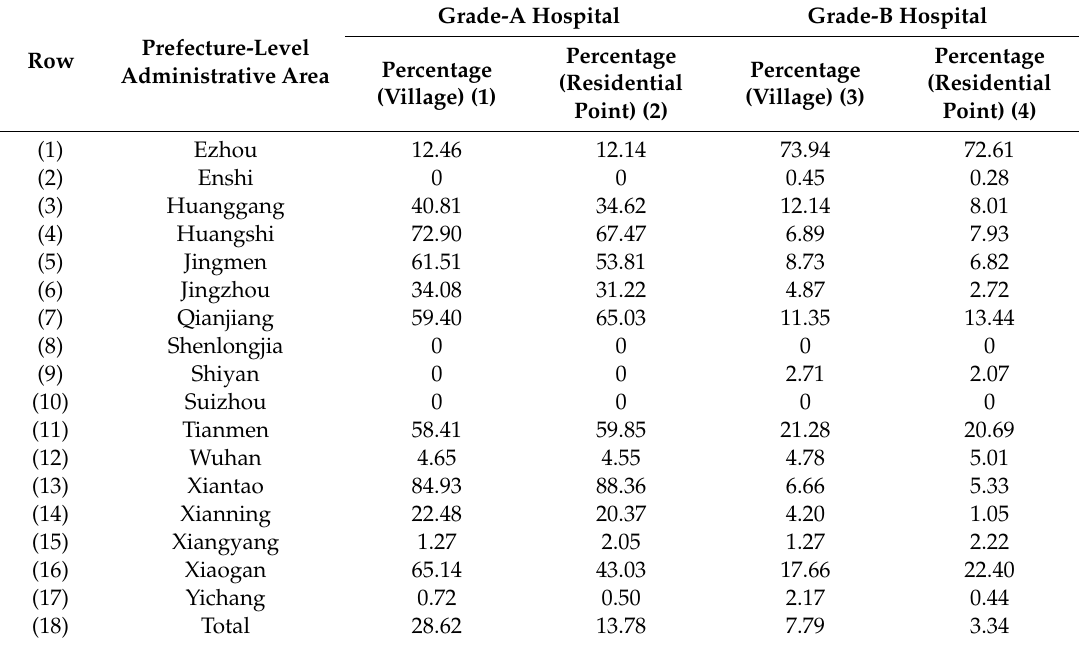
Table 4. Reimbursement inconvenience proportions per